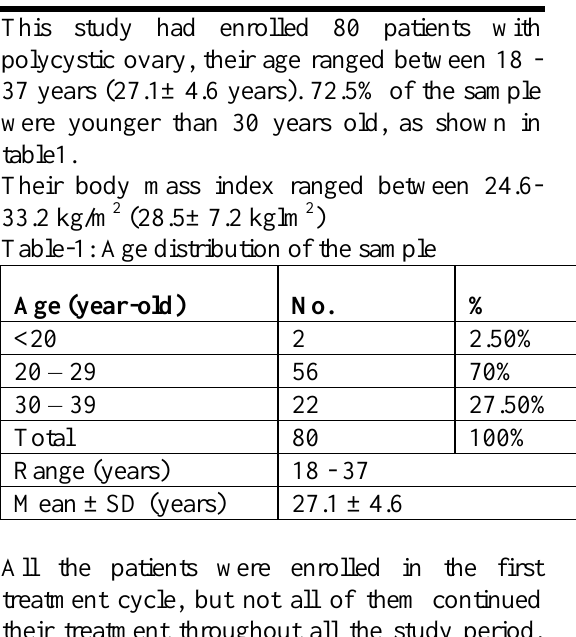
Figure-1: number of patients included in each treatment cycles